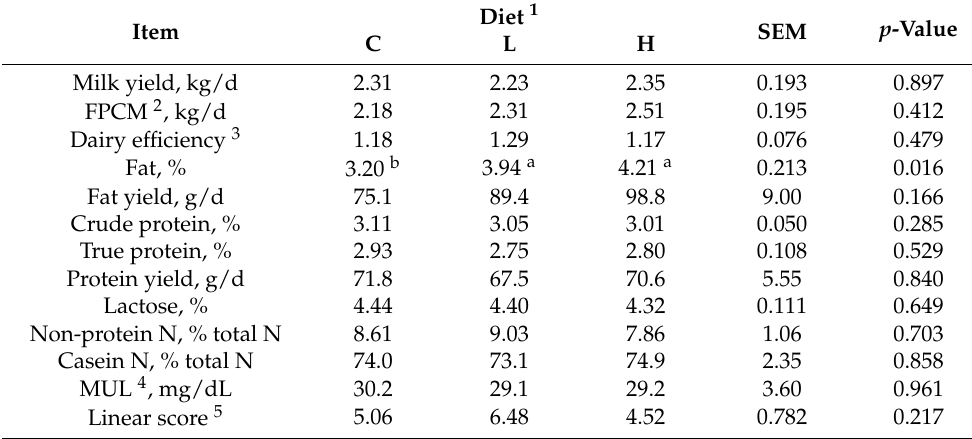
Table 5. Milk yield and composition of the goats fed the three experimental